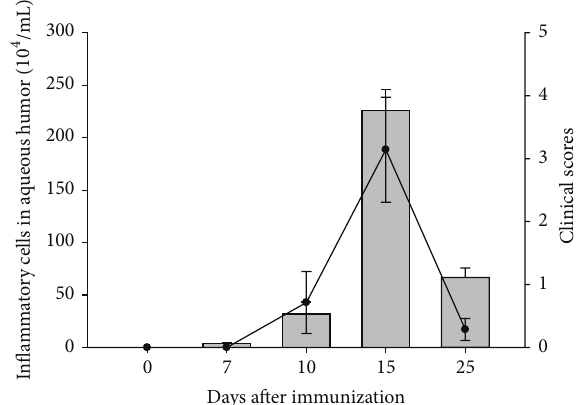
Figure 1: Clinical scores and inflammatory cells in aqueous humor following induction of EAAU. The concentrations of the inflamma- tory cells are shown in the bar chart, while the clinical scores are represented by the line graph. EAAU: experimental autoimmune anterior